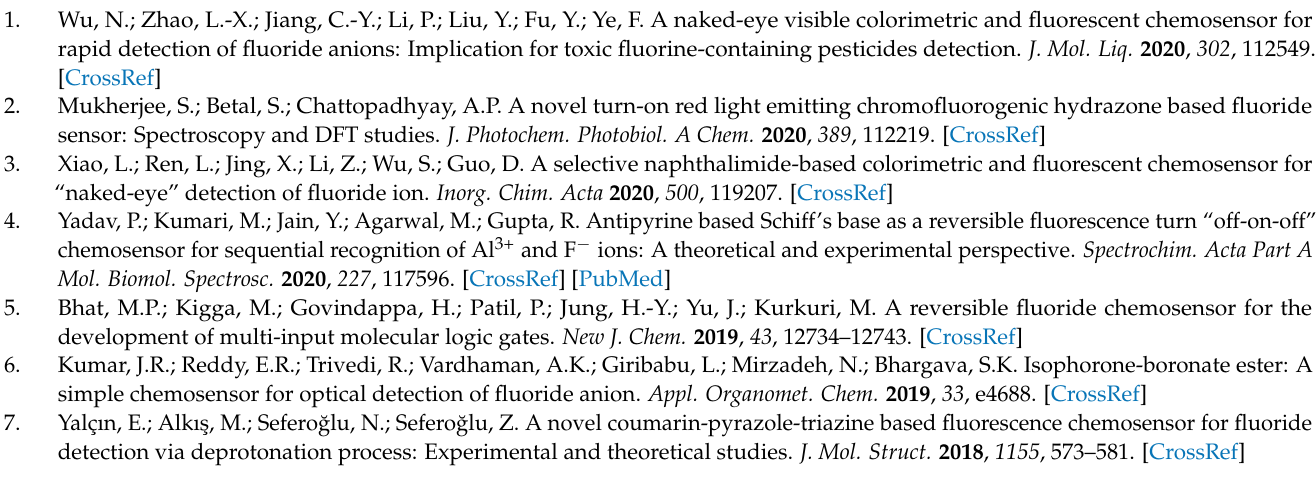
the stoichiometric ratio between DTITPE and F − in THF by Job’s plot, Figure S16: a 1 H NMR Spectra of DTITPE and DTITPE.F − , b, 1 H NMR spectrum of the molecular sensor DTITPE with incremental addition of TBAF, in CDCl 3 at room temperature, Figure S17: Optimized geometry of DTITPE, (b) Electrostatic potential (ESP) (isovalue = 0.02) surfaces of DTITPE, (c) Top view of DTITPE, and d) Side view of DTITPE, Figure S18: DFT optimized electronic distributions of DTITPE for various HOMO and LUMO energy levels, Figure S19: (a) Optimized geometry of DTITPE.F − (b) Electrostatic potential (ESP) (isovalue = 0.02) surface of DTITPE.F − (c) Top view of DTITPE.F − , and (d) Side view of DTITPE.F − , Figure S20: DFT optimized electronic distributions of DTITPE.F − at various HOMO and LUMO energy levels, Figure S21: (a) Optimized geometry of deprotonated DTITPE − , (b) The electrostatic potential (ESP) (isovalue = 0.02) surface of DTITPE − , (c) Top view of DTITPE − , and (d) Side view of DTITPE − , Figure S22: DFT optimized electronic distributions of DTITPE − at various HOMO and LUMO energy levels, Figure S23: Theoretical UV-vis. spectra for DTITPE and DTITPE.F − calculated using TD-DFT/B3LYP/6-31+G(d,p) with the CPCM method using THF as solvent, Table S1: Calculated bond lengths and dihedral angles of DTITPE, DTITPE.F − and DTITPE − using B3LYP/6-31+G(d,p) method, Table S2: Calculated HOMO and LUMO energies and band gaps for DTITPE, DTITPE.F − and DTITPE − calculated using B3LYP/6-31+G(d,p) method, Table S3: Theoretical energy levels and MO character for DTITPE, DTITPE.F − and DTITPE − calculated using TD-DFT/B3LYP/6-31+G(d,p) with CPCM method using THF as solvent, Table S4: Comparison of the imidazole derived molecular sensors and their sensing properties, Table S5: Crystal data and structure refinement for